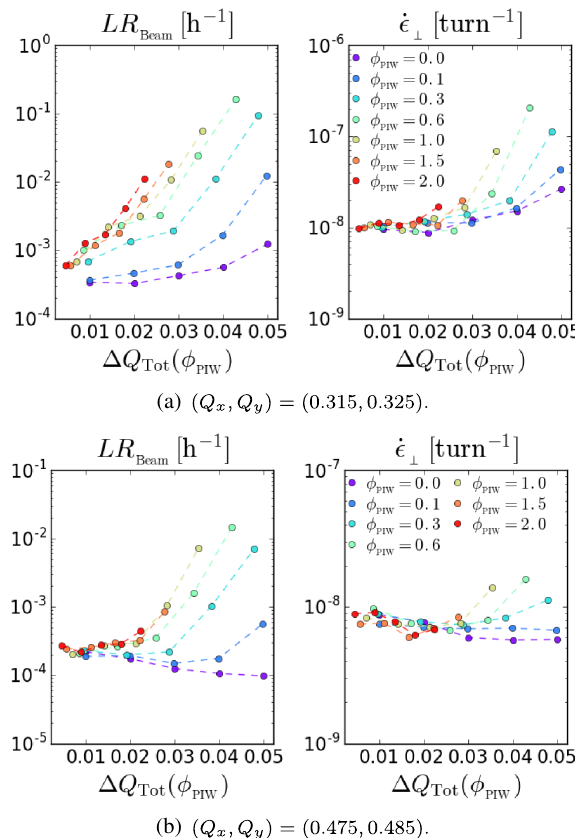
FIG. 10. Beam quality reduction for different combinations of ϕ and ξ at different working points, when Q 0 ¼ 15 and PIW Tot β (cid:1) 0 . 4 m. q ¼